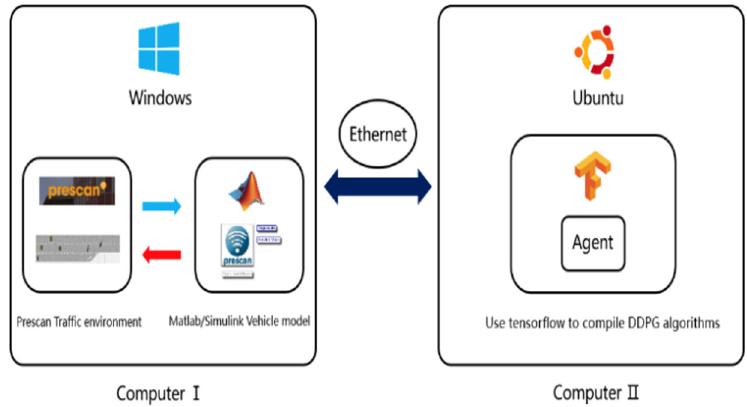
Figure 8. RL co-simulation platform.